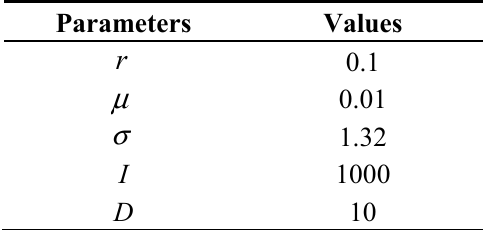
Table 3. Parameters for numerical examples.